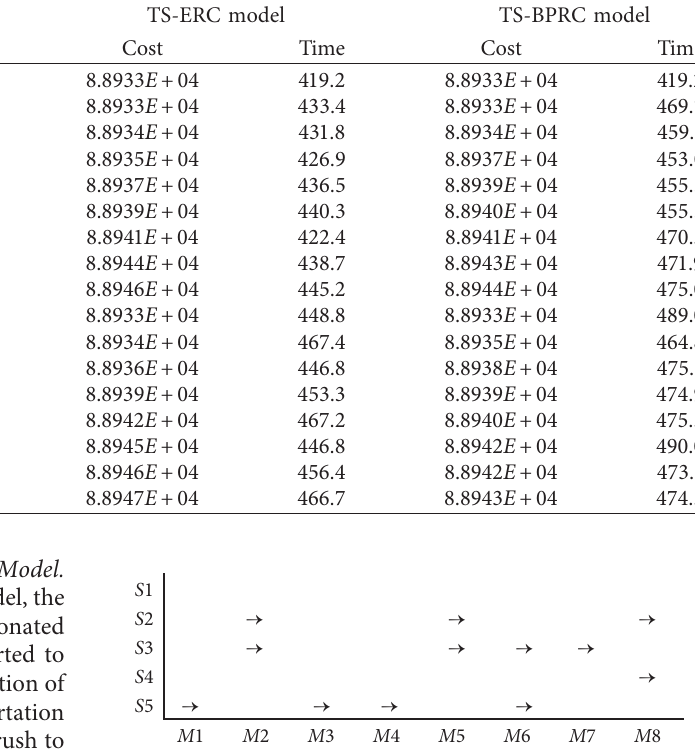
Figure 3: Distribution route of the TS-SCC model.